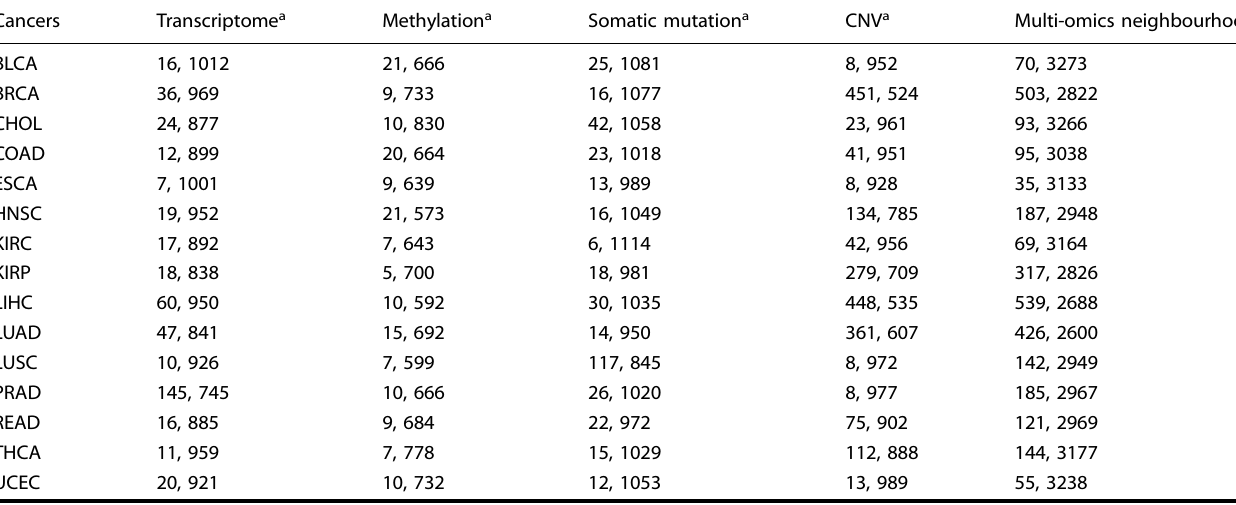
Table 2. The size of the core and peripheral regions of 15 cancers in four omics